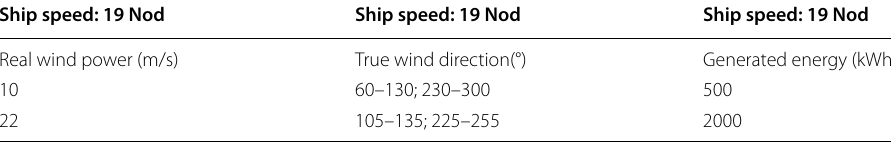
Table 2 Energy generated by the large vertical wind turbine (Vasilescu 2020) Ship speed: 19 Nod